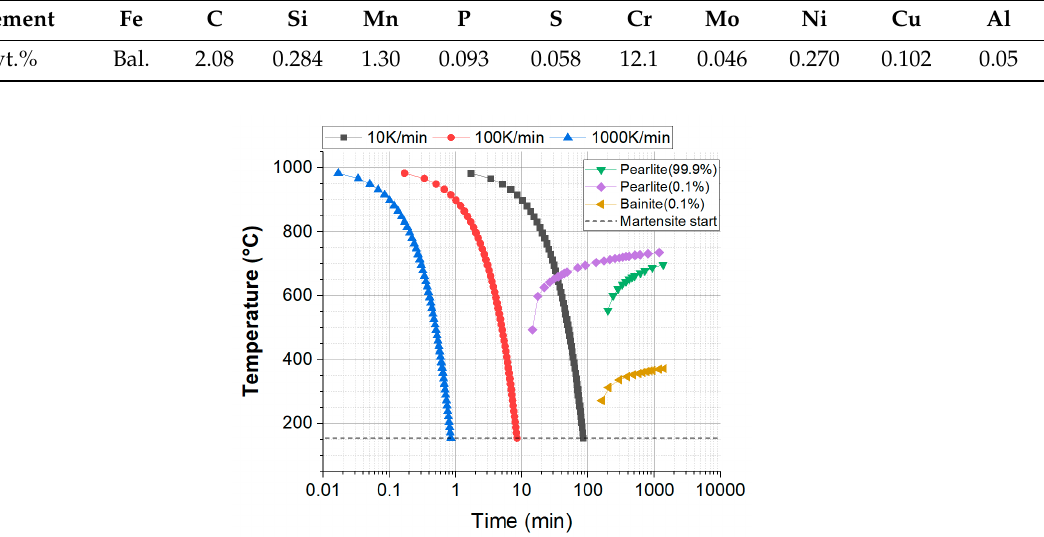
Figure 1. JMatPro simulation of continuous-cooling transformation diagram for the alloy.